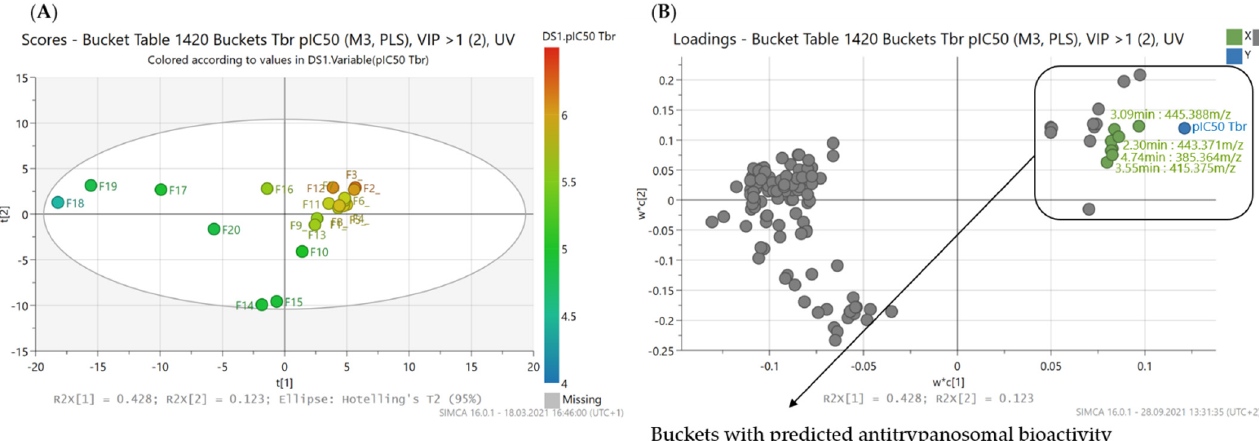
Figure 4. PLS model with prediction of antitrypanosomal compounds from B . sempervirens L. ( A ) Scores plot of the second vs. the first PLS component of the PLS model. Coloration indicates the bioactivity against Tbr of the fractions ranging from a pIC 50 value of 4.41 (F18, blue) to a value of 6.2 (F2, red); ( B ) corresponding loadings plot to ( A ). The buckets marked with a box in the upper right quadrant are predicted to possess high antitrypanosomal activity by the PLS model (Buckets marked and labeled in green are detailed in Figure 5).